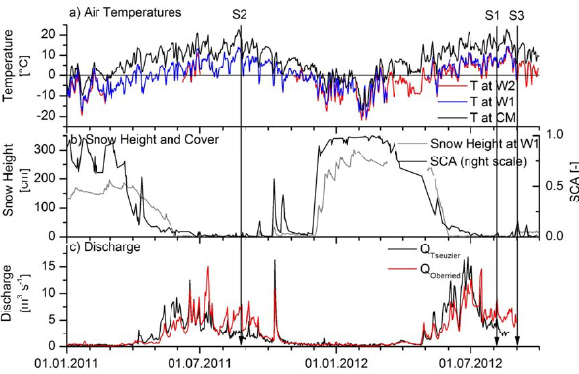
Fig. 4. Hydro-meteorological observations in the region of the Glacier de la Plaine Morte: (a) illustrates mean daily air temper- atures at W1, W2 and CM; (b) shows the snow height at W1 and the ratio of snow cover area (SCA) in the entire watershed depicted in Fig. 1; and (c) displays mean daily total discharge into Lac de Tseuzier ( Q Tseuzier ) and at Oberried ( Q Oberried ) . S1, S2 and S3 illustrate tracer injection dates.